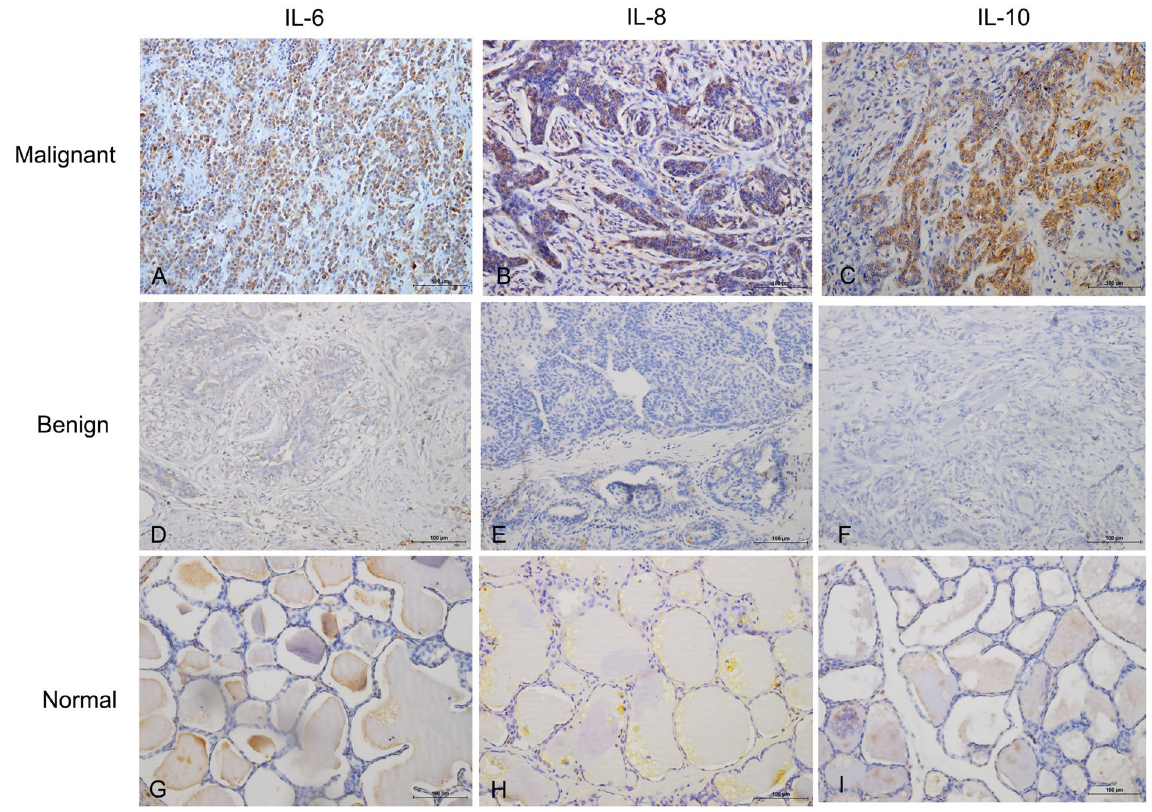
Figure 2. Immunohistochemical staining of IL-6, IL-8 and IL-10 in CMGTs and normal canine mammary gland tissues. Representative images (200X) show IHC staining of ( A , D and G ) IL-6, ( B , E and H ) IL-8 and ( C , F and I ) IL-10 in CMGTs and normal canine mammary gland tissue sections. Both cell membrane and cytoplasmic staining is indicated.